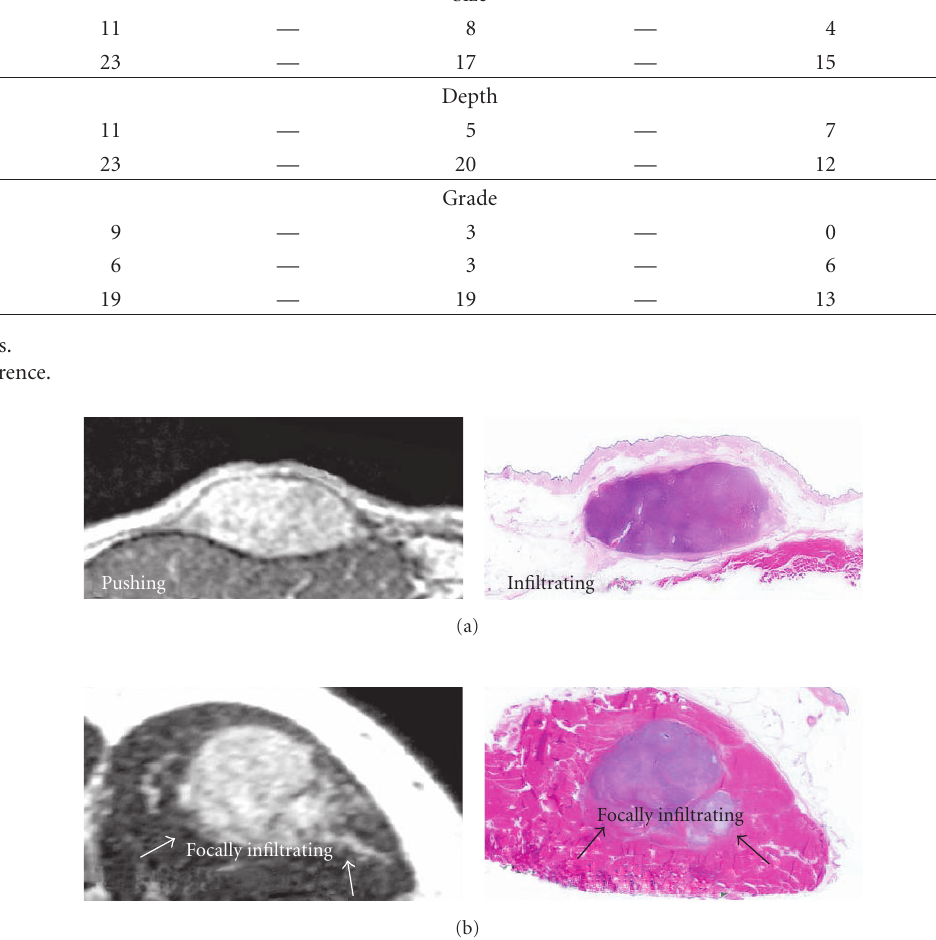
Figure 1: Examples of MRI scans and whole-tumour sections stained with haematoxylin and erythrosine from 2 di ff erent leiomyosarcomas; (a) a subcutaneous tumour of the thigh with a pushing growth pattern on MRI, but microscopic infiltration on histopathology, (b) an intramuscular tumour of the thigh with focally infiltrative growth pattern on both MRI and histopathology.